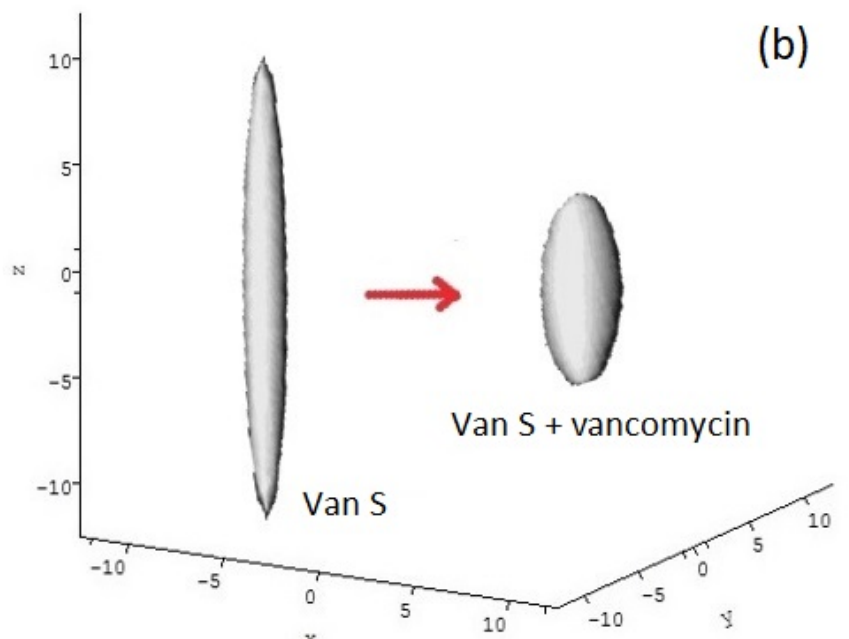
Figure 1. Hydrodynamics of enterococcal VanS ( a ) Sedimentation coefficient concentration distribution, c( s ) vs. s profile from SEDFIT analysis [35] for VanS (black profile) in aqueous buffer pH ~7.9, I = 0.1 M (supplemented with 20% glycerol) at 20.0 °C and a loading concentration of 0.25 mg/mL (5.4 μ M). Additionally, shown is the profile for vancomycin 0.019 mg/mL (12.8 μ M) (grey profile) and a mixture of VanS and vancomycin (red profile) under the same conditions. ( b ) Hydrodynamic shape (equivalent prolate ellipsoid) of the enterococcal VanS protein from ELLIPS1 [31] in the absence (left) and presence (right) of vancomycin. The shift in the sedimentation coefficient is equivalent to a reduction in axial ratio of the equivalent prolate hydrodynamic ellipsoid from ~12:1 to a more compact structure of axial ratio ~5:1. Adapted from Phillips-Jones et al. [3] and reproduced by permission from the Nature Publishing